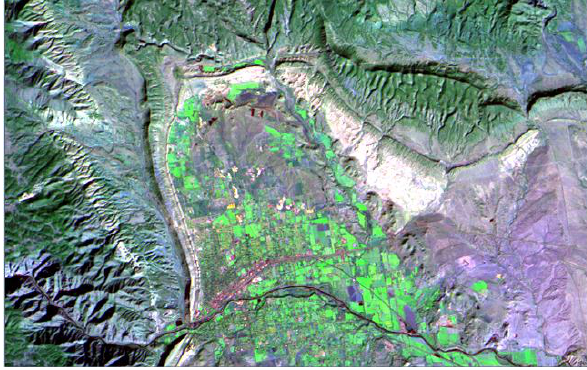
Figure 4. the remote sensing image for test